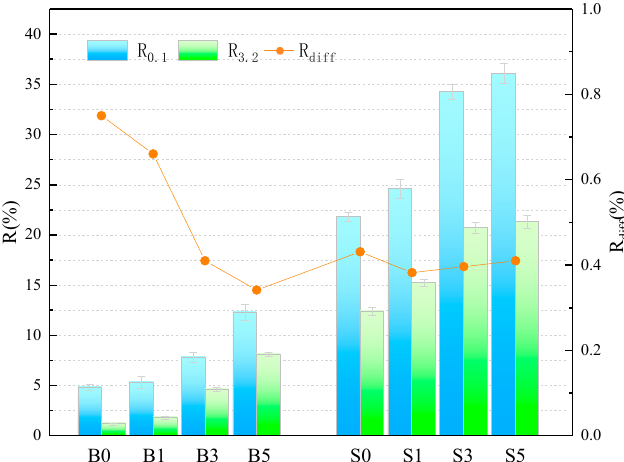
Figure 3. Calculation of the relevant parameters for the R.